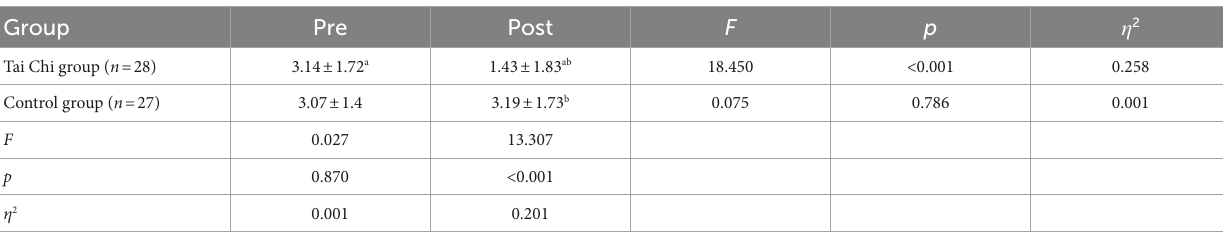
TABLE 6 Results of repeated measures ANOVA c for dominance difference (M ± SD). Group Pre